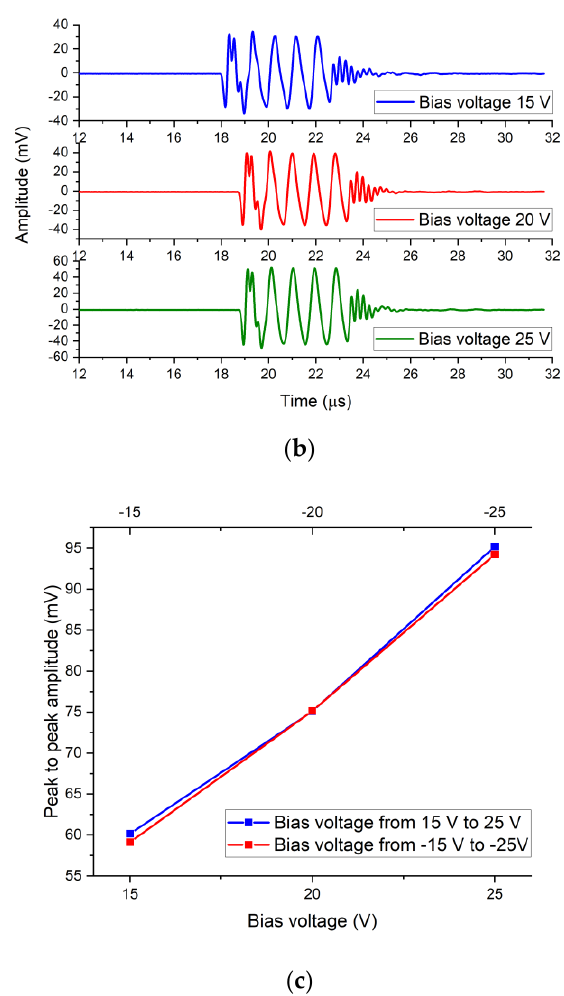
Figure 7. ( a ) Response waveforms of the hydrophone when the CMUT was driven by the DC bias voltages from −15 V to −25 V; ( b ) response waveforms of the hydrophone when the CMUT was driven by the DC bias voltages from 15 V to 25 V; ( c ) peak-to-peak response amplitude of the hy- drophone when the CMUT was driven by different DC bias